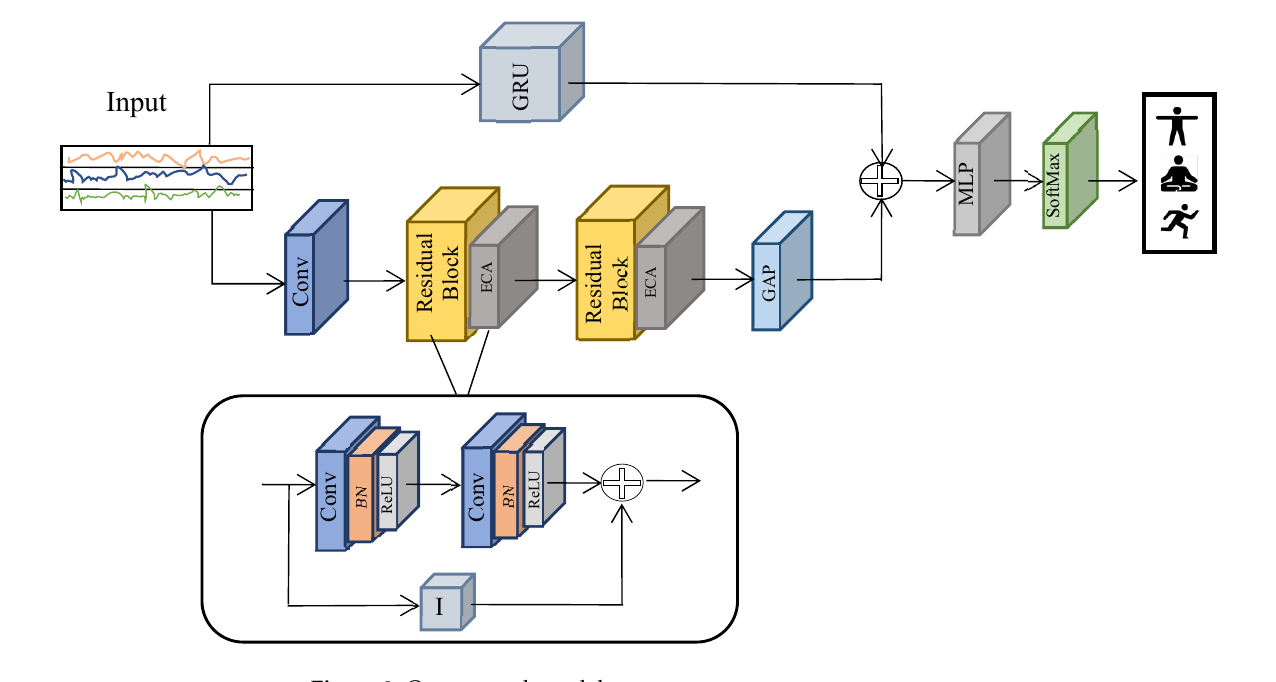
Figure 2. our network model. Figure 2. Our network